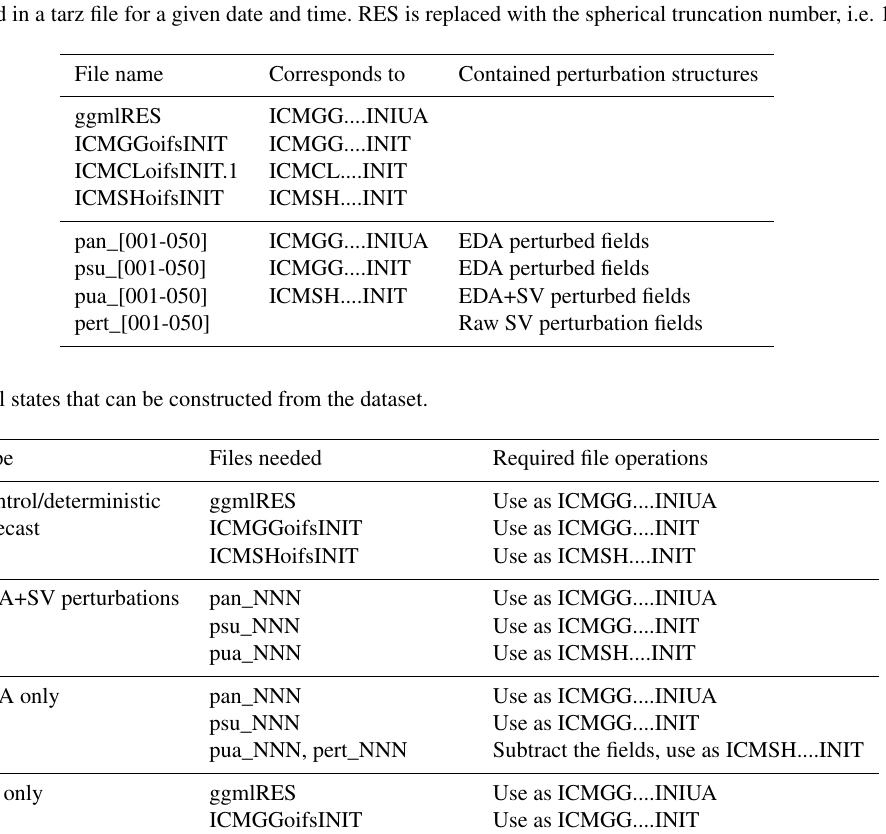
Table 2. Files contained in a tarz file for a given date and time. RES is replaced with the spherical truncation number, i.e. 159 / 399 / 639. File name Corresponds to